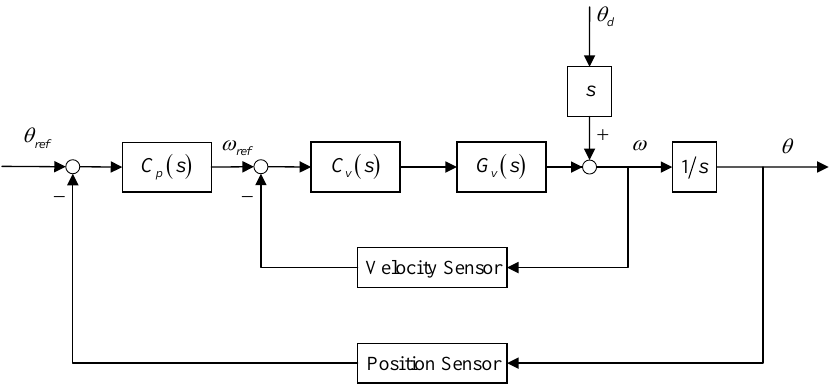
Figure 6. The block diagram of